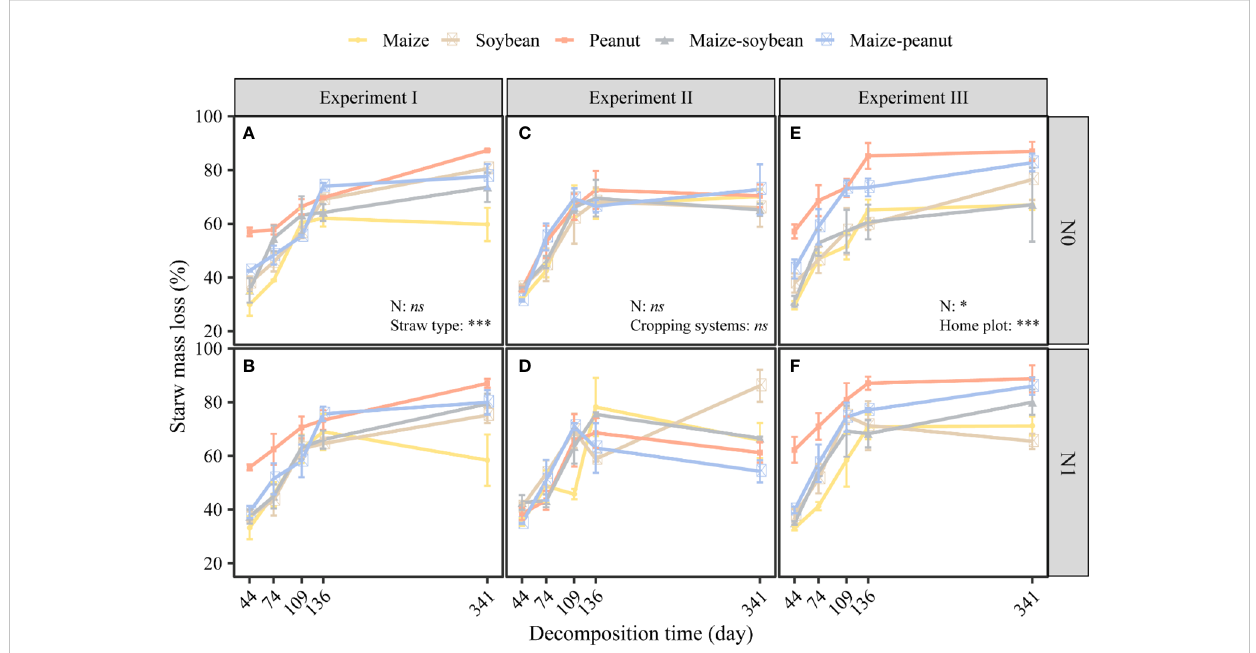
(Table 1). The initial C/N ratios as well as C and